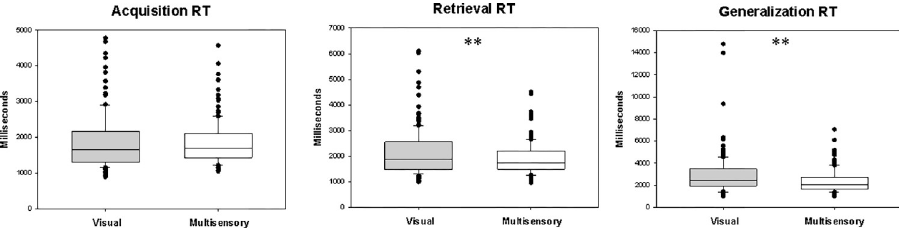
Fig 3. Reaction times in the visual and multisensory paradigms (in milliseconds). The reaction times did not differ significantly between the visual and audiovisual paradigms in the acquisition phase. The conventions are the same as in Fig